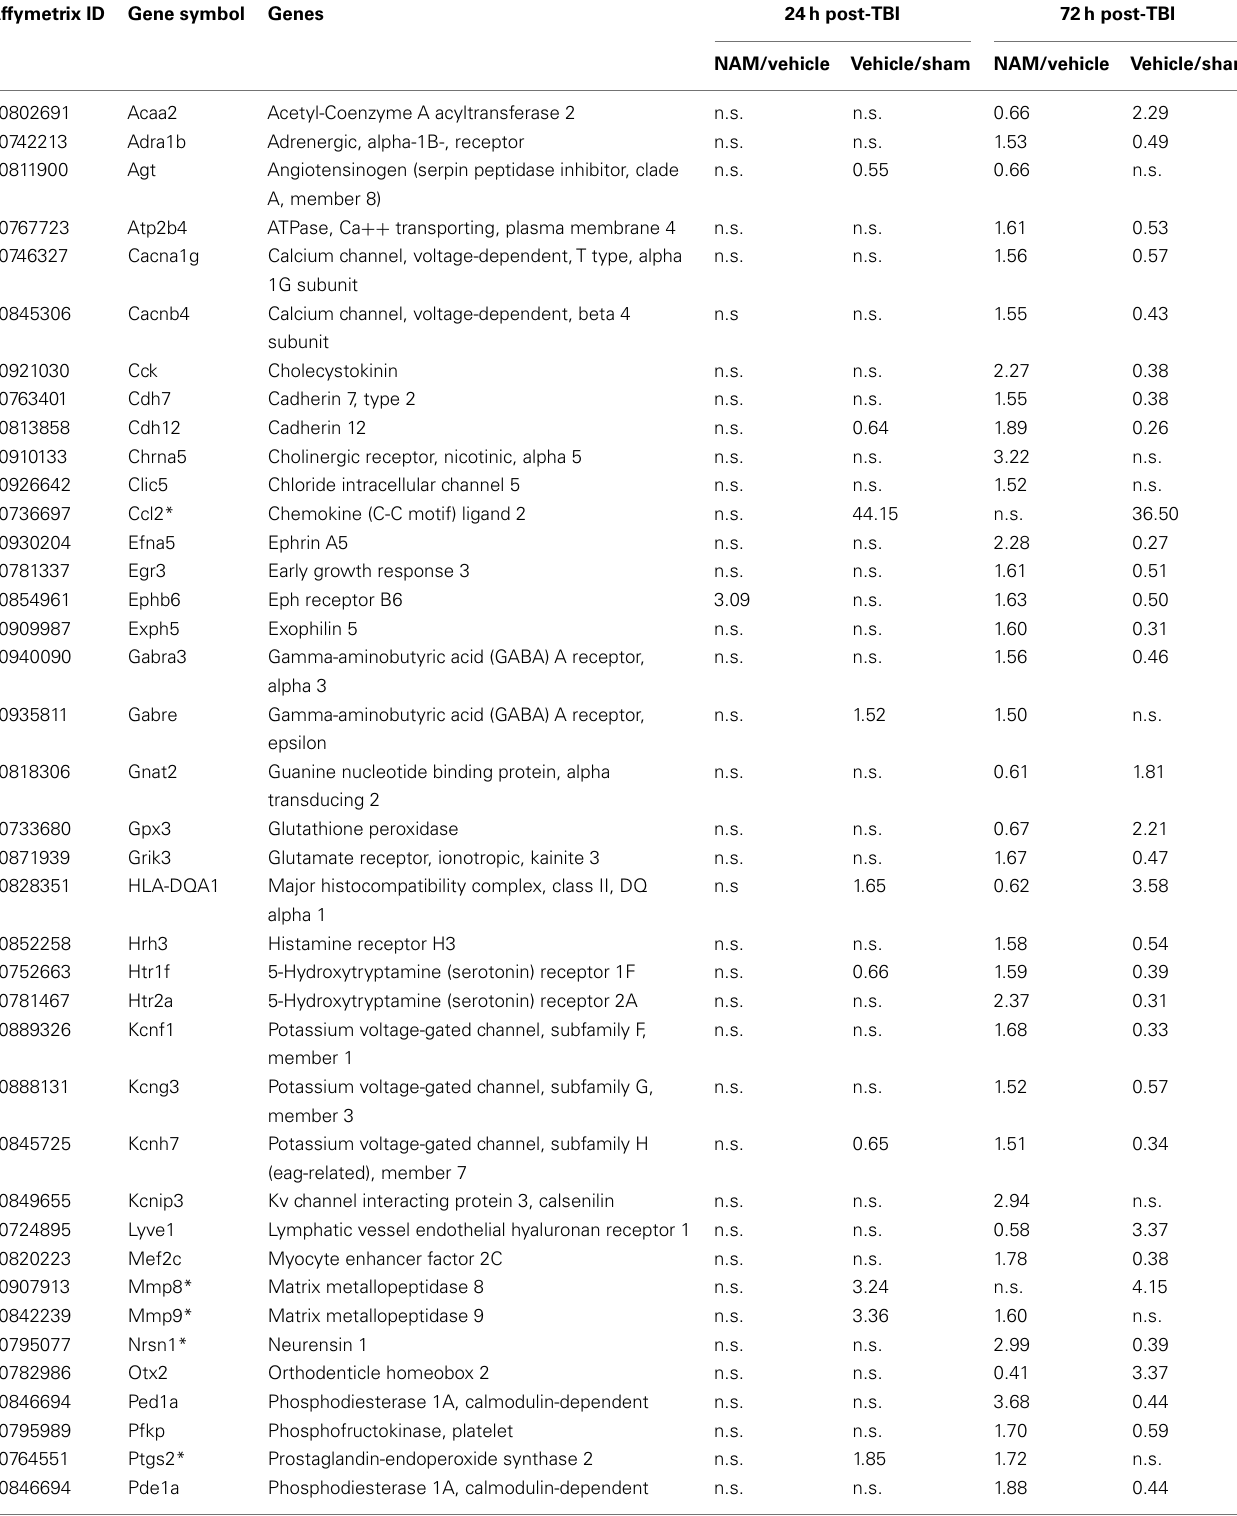
Table 5 |The effect of NAM treatment (NAM/vehicle) andTBI (vehicle/sham) on differentially expressed genes associated with significant functional categories and canonical pathways identified by IPA at 24h